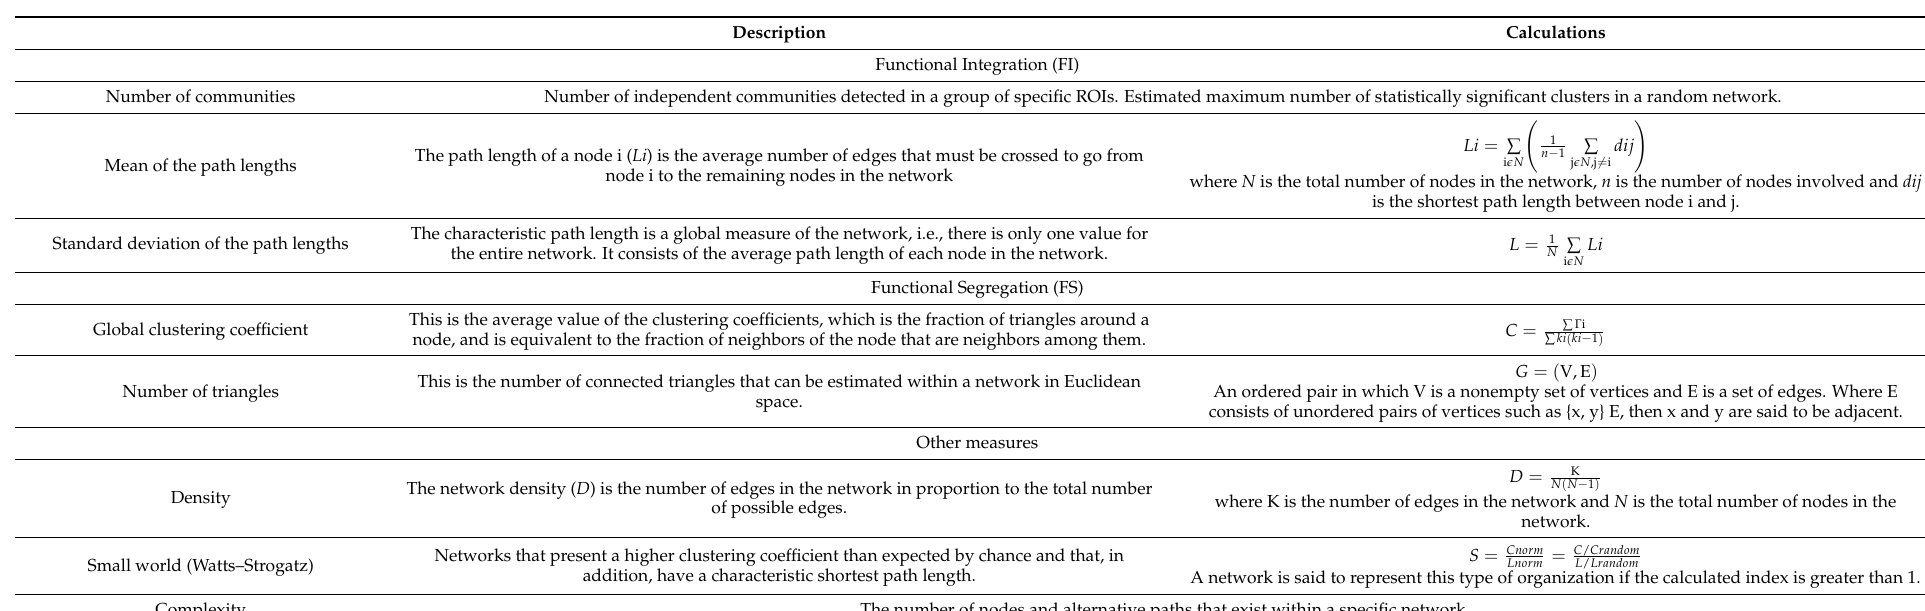
Table 2. List of estimated weighted indicators to determine the characteristics of each network